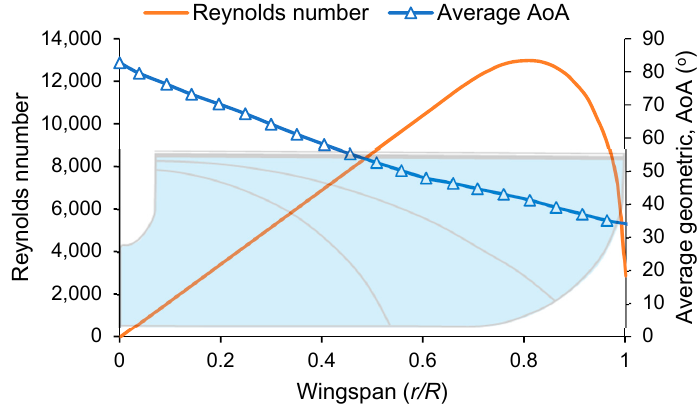
Figure 4. Average geometric angles of attack during translational stages (Phan et al. [21]) and distribution of Reynolds numbers along the wingspan.